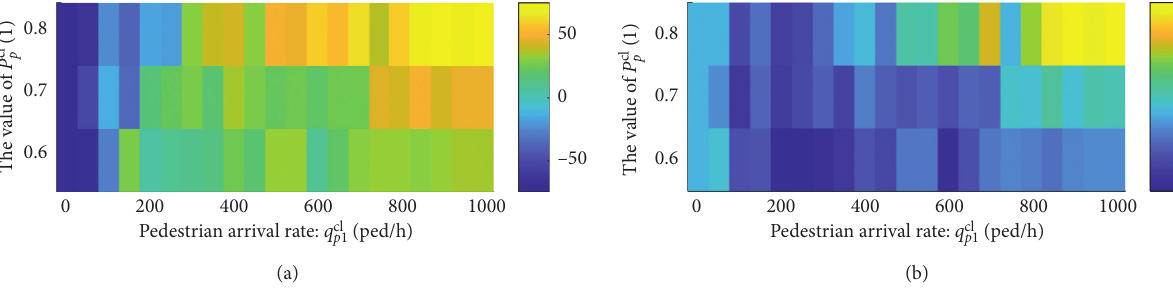
Figure 10: (a) Absolute error and (b) relative error between microscopic simulation and model